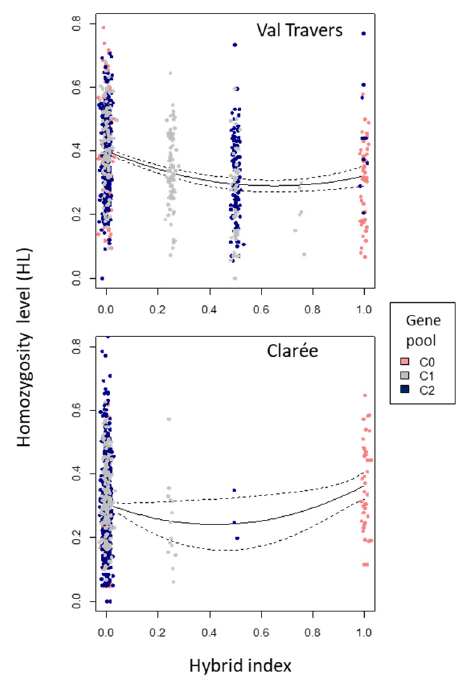
Figure 3. Relationship between Hybrid Index and Homozygosity Level for Val travers ( top panel) and Clarée ( bottom panel). The Hybrid index is 0 for local individuals, 0.25 for F1xlocal, 0.5 for F1 and F2, 0.75 for F1xforeign, and 1 for foreign individuals. Red, blue and green dots indicate C0, C1 and C2 individuals respectively. Jittering was added to the X coordinates to improve visibility. The full line represents the polynomial model prediction, the interrupted lines indicating the standard error around this fit. Table 4. ANOVA analysis of the linear models testing for the linear and non-linear effects of Hy- brid Index on individual Homozygosity Level in Val Travers and Clarée populations.